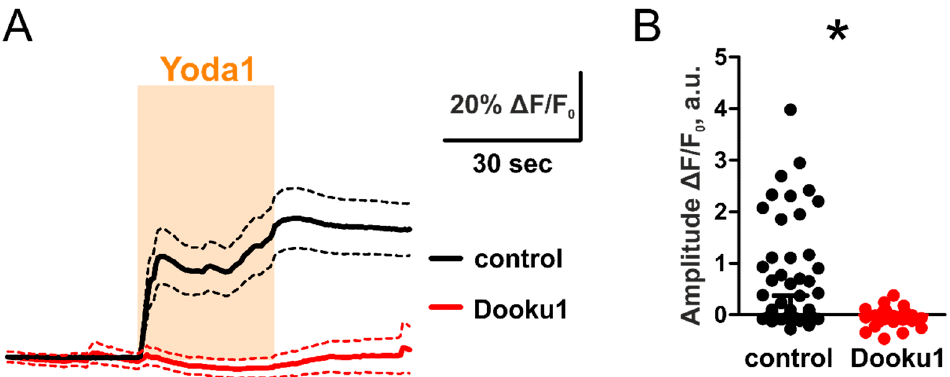
Figure A2. Chip-based setup. Solution input was driven by gravity, solution output was precisely controlled by microfluidic syringe pump with two syringes individually connected to two cell com- partments. Close up panel demonstrates microfluidic chip in assembly with chip insert. Arrows show direction of solution flow.